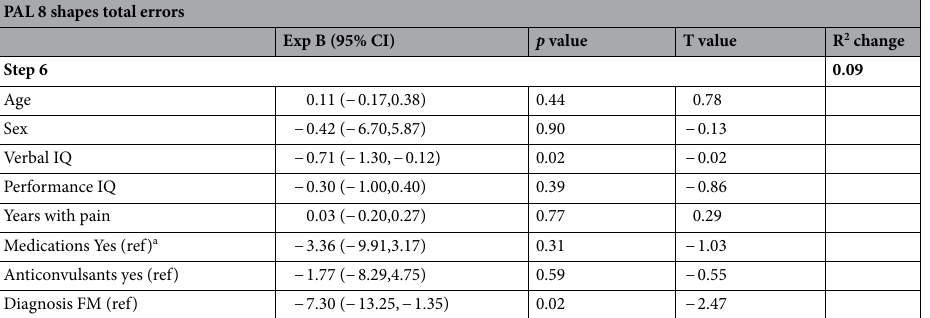
PAL 8 shapes total